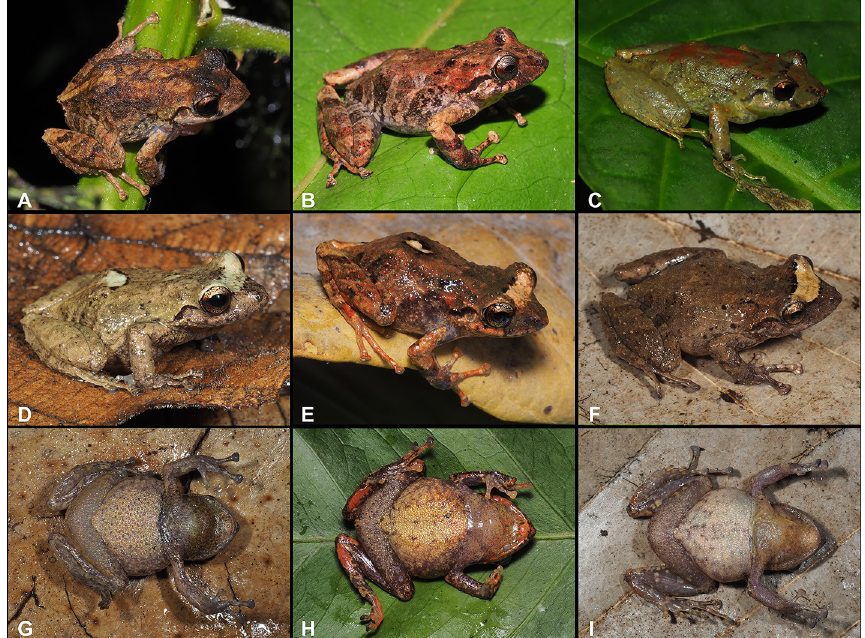
Fig 9. Color variation in males of Pristimantis lojanus sp. nov. in life. A. Not collected, Loja city, Parque Universitario de Educacio´n Ambiental y Recreacio´n “Francisco Vivar Castro” (PUEAR); B. Paratype, (MUTPL 179), SVL 27.1 mm, Loja city, Quebrada El Carmen; C. Not collected, PUEAR; D and G Paratype, (MUTPL 1030), SVL 28.5 mm, Loja city, Cerro Chiriaco; E and H Paratype, (MUTPL 191), SVL 26.2 mm, Cristal; F and I Paratype, (MUTPL 936), SVL 30.4 mm, Cerro Sacama; A–F Dorsolateral views; G–I Ventral views. https://doi.org/10.1371/journal.pone.0258454.g009 concealing the upper and posterior margin of the tympanum; (3) snout acuminate with a verti- cal keel in dorsal view, rounded or subacuminate and inclined posteroventrally in profile; can- thus rostralis weakly concave in dorsal view, rounded in profile; (4) upper eyelid bearing